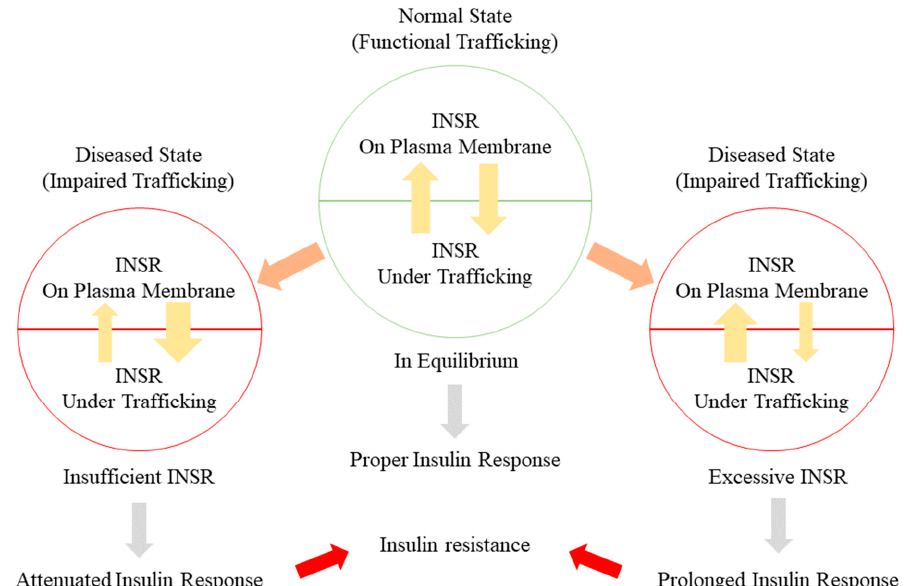
Figure 2. Insulin resistance can be caused by impaired INSR tra ffi cking. The amount of INSR on the plasma membrane and intracellular is maintained in equilibrium. Under normal conditions, a su ffi cient level of INSR is able to sustain a continuous insulin response under insulin stimulation. In a diseased state when INSR trafficking is damaged, INSR is either trapped intracellularly or restricted on the plasma membrane. Either insu ffi cient or excessive INSR will trigger an altered insulin response and contribute to the development of insulin resistance. Table 1. Mutation of INSR under di ff erent conditions with severe insulin resistance. Condition